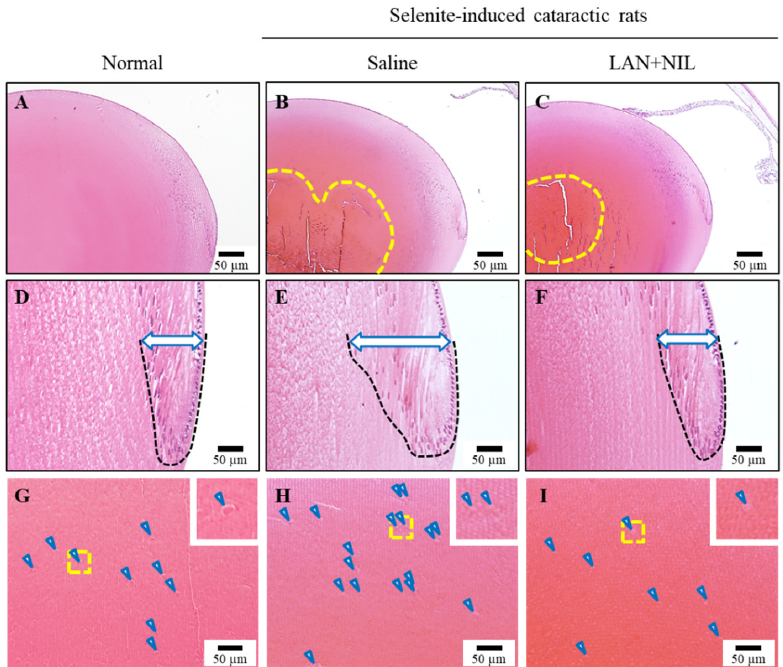
Figure 7. Lens structure of sodium-selenite-induced cataractic rats repeatedly co-instilled with LAN-ONSs and NIL-ONSs. ( A – C ): total lens. Yellow area represents the perinuclear refractile ring. ( D – F ): equatorial bow region of the lens. Black dotted line and blue arrowhead denote the delay of morphological differentiation. ( G – I ): lens fiber area on anterior capsule side. Blue arrowhead denote swollen fibers. Twenty microliters of ophthalmic formulations (0.5% LAN or 0.6% NIL), shown in Table 1, were instilled one time/day for 28 days. The start day and the end day of dosing were 7 and 35 days, respectively. The lens structure was measured at 35 days after the injection of sodium selenite. Scale bar, 50 µ m. Normal, lens structure in normal rats. Saline, lens structure in sodium-selenite-induced cataractic rat repeatedly instilled with saline. LAN + NIL, lens structure in sodium-selenite-induced cataractic rat repeatedly co-instilled with LAN-ONSs and NIL-ONSs. The sclerotic lens nucleus (perinuclear refractile ring), the delay of morphological differentiation, and increased number of swollen fibers in sodium-selenite-induced cataractic rats were attenuated by